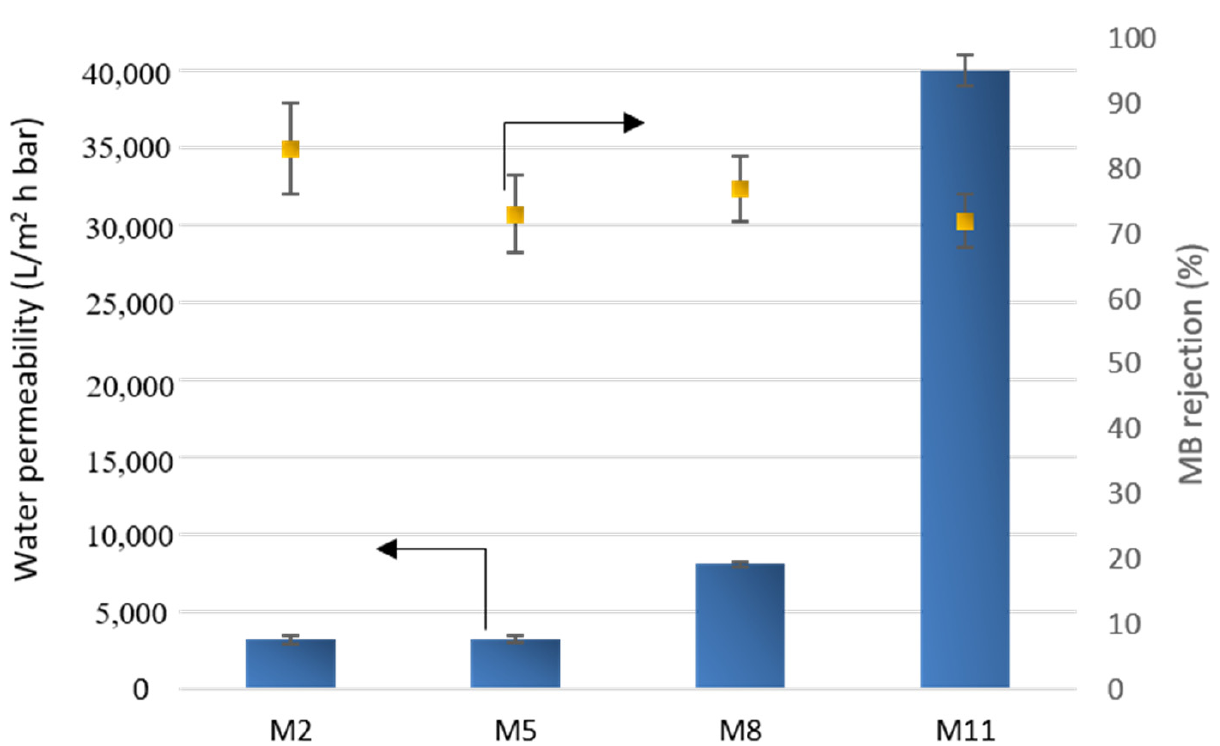
Figure 14. Water permeability and MB rejection of selected membranes.